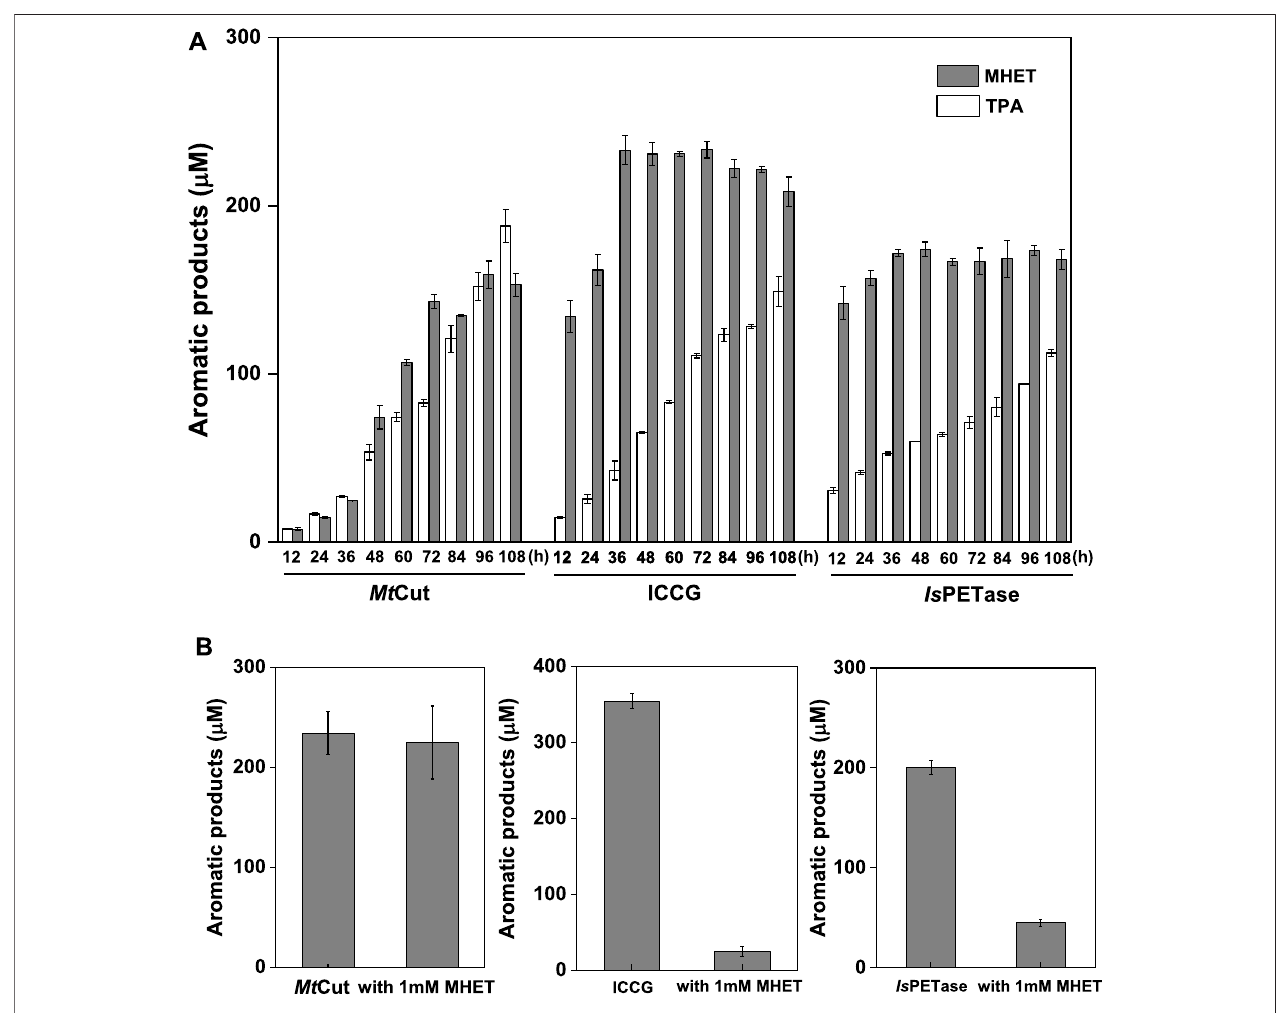
FIGURE4| Productreleaseandinhibition. (A) Productquanti fi cationofmp-PEThydrolysisby Mt Cut,ICCG,and Is PETaseenzymesover108 hat40 ° C,with2 mg/ mlPETand10 μ g/mlenzyme. (B) TheinhibitoryeffectsofMHETata fi nalconcentrationof1 mMon Mt Cut,ICCG,and Is PETaseactivities.PEThydrolysisproductswere analyzed in a 72 h reaction under standard